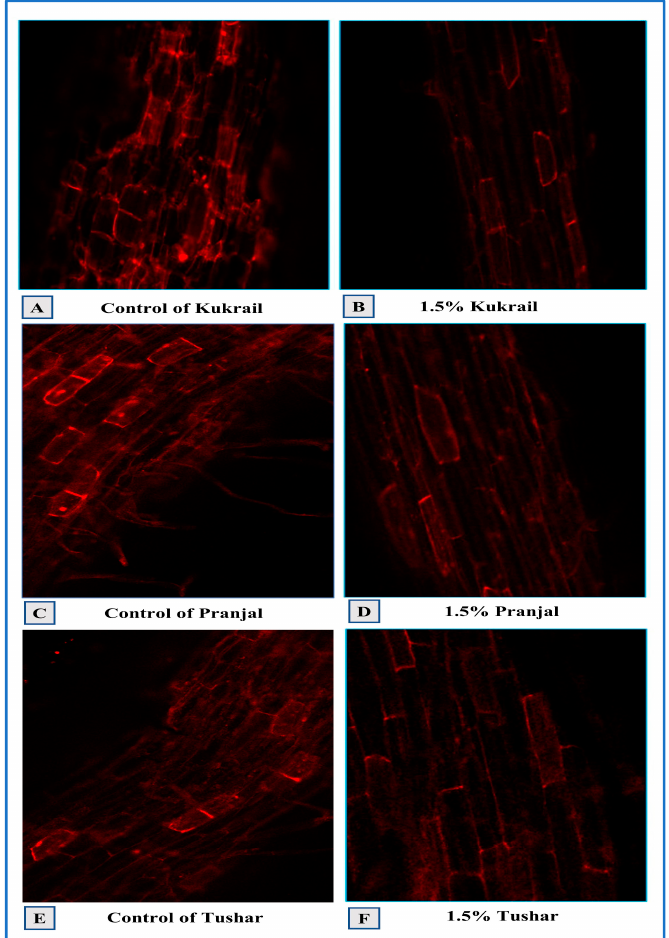
Figure 7. Confocal microscopy depicting the cellular viability of peppermint cultivars. The cellular viability in control plants showed higher fluorescence confirming a large number of dead cells. In contrast, cellular viability at 1.5% N having the lesser fluorescence depicts the enhanced cellular viability in the studied cultivars. ( A ) control of Kukrail, ( B ) 1.5% Kukrail, ( C ) control of Pranjal, ( D ) 1.5% Pranjal, ( E ) control of Tushar, ( F ) 1.5%